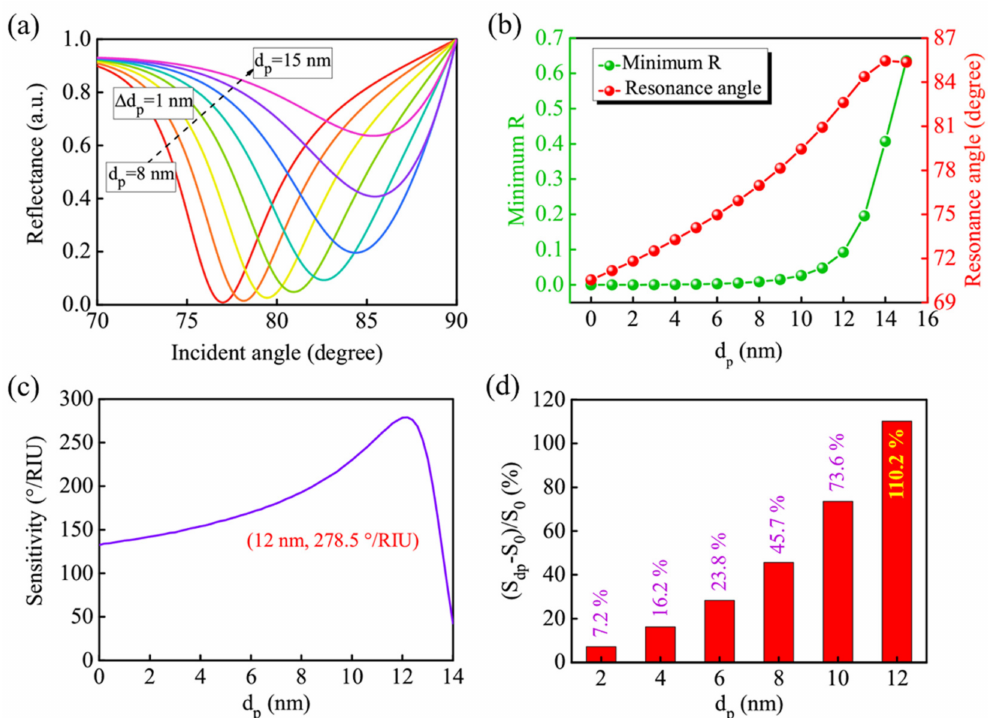
Figure 3. ( a ) The variation of the resonance signal when the thickness of the guided-wave layer changes from 8 nm to 15 nm. ( b ) The variation of minimum R and the resonance angle under different thicknesses of CH 3 NH 3 PbBr 3 perovskite thin film ( d p ). ( c ) The sensitivity of the proposed GWSPR biosensor with different thicknesses of guided-wave layer to obtain the optimal thickness of CH 3 NH 3 PbBr 3 perovskite thin film. ( d ) Sensitivity enhancement of the proposed GWSPR sensor compared with the conventional SPR sensor. The result demonstrates that the highest sensitivity is 278.5 ◦ /RIU at d p = 12 nm, which is improved by 110.2% compared with the conventional SPR